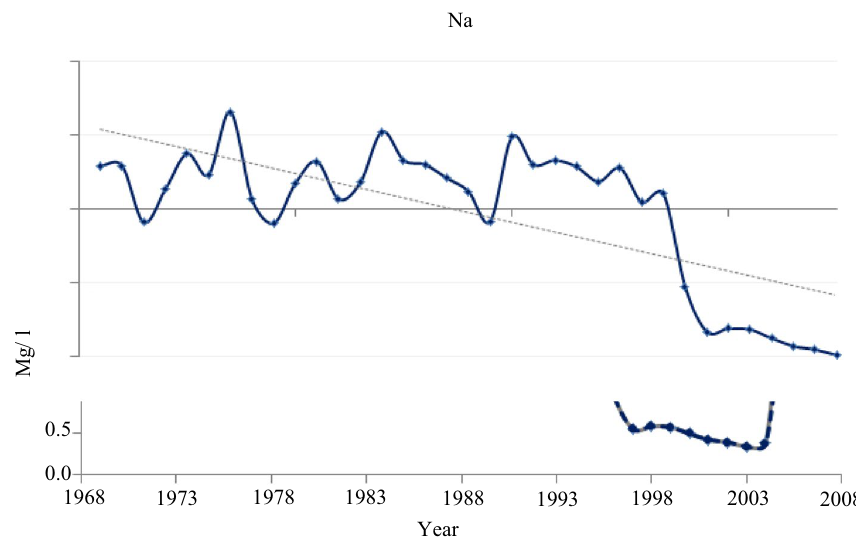
Fig. 9 Unchanging time arrangements of Na + and the foretold values for 5 years